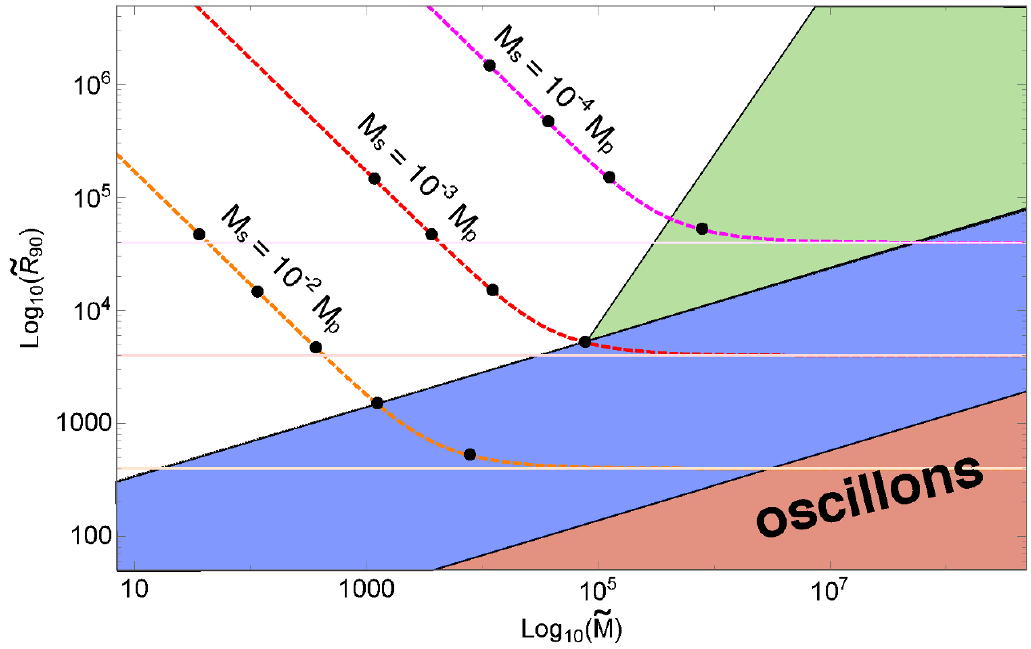
JHEP08(2018)070 Figure 4 . We plot the radii of the moduli stars (for blow-up potentials) as a function of the star mass. Di(cid:11)erent dots correspond to numerical solutions obtained varying the core amplitude ~ (cid:27) core for di(cid:11)erent values of the string scale M s . In particular, from left to right the dots rep- (cid:0) (cid:1) resent the solutions for the core amplitudes 10 (cid:0) 6 ; 10 (cid:0) 5 ; 10 (cid:0) 4 ; 10 (cid:0) 3 ; 10 (cid:0) 2 for M s = 10 (cid:0) 2 M P , (cid:0) (cid:1) (cid:0) (cid:1) 10 (cid:0) 6 ; 10 (cid:0) 5 ; 10 (cid:0) 4 ; 10 (cid:0) 3 for M s = 10 (cid:0) 3 M P and 10 (cid:0) 7 ; 10 (cid:0) 6 ; 10 (cid:0) 5 ; 10 (cid:0) 4 for M s = 10 (cid:0) 4 M P . Dashed lines are found matching the numerical data with the function de(cid:12)ned in eq. (3.29). The solid horizontal lines correspond to the asymptotic values de(cid:12)ned in eq. (3.30). The blue region corresponds to a background amplitude ~ (cid:27) core & 10 (cid:0) 3 , where the approximations used are not fully reliable, while the green region corresponds to the regime in which interactions become important due to the large mass of the star, as explained in the main